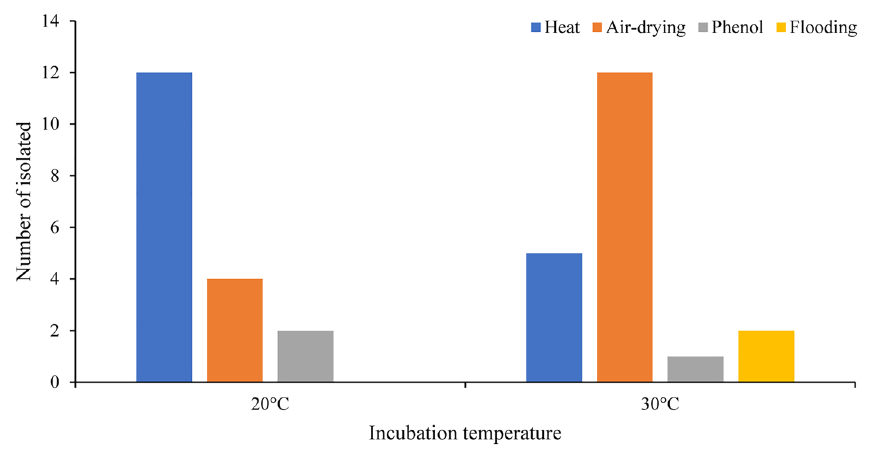
Figure 6. Number of actinobacteria isolated from different incubation